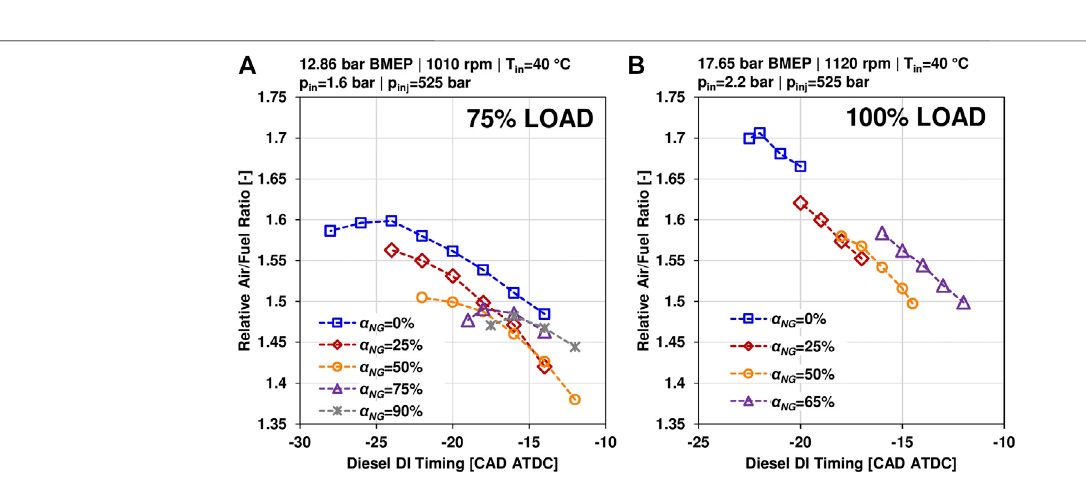
FIGURE 11 | Relative air/fuel ratio – (A) . 75% load; (B) . 100%